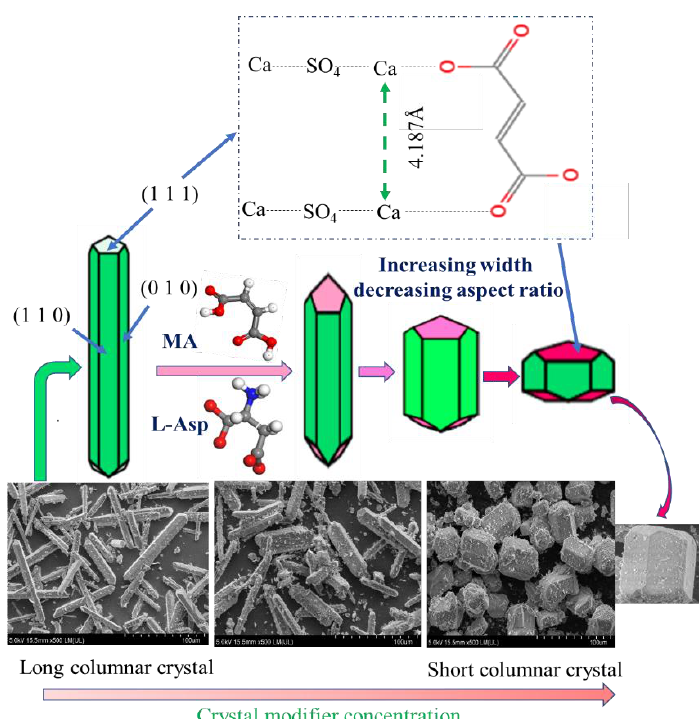
Figure 15. Model of CaSO 4 · 0.5H 2 O crystal habit regulated by the crystal modifier.